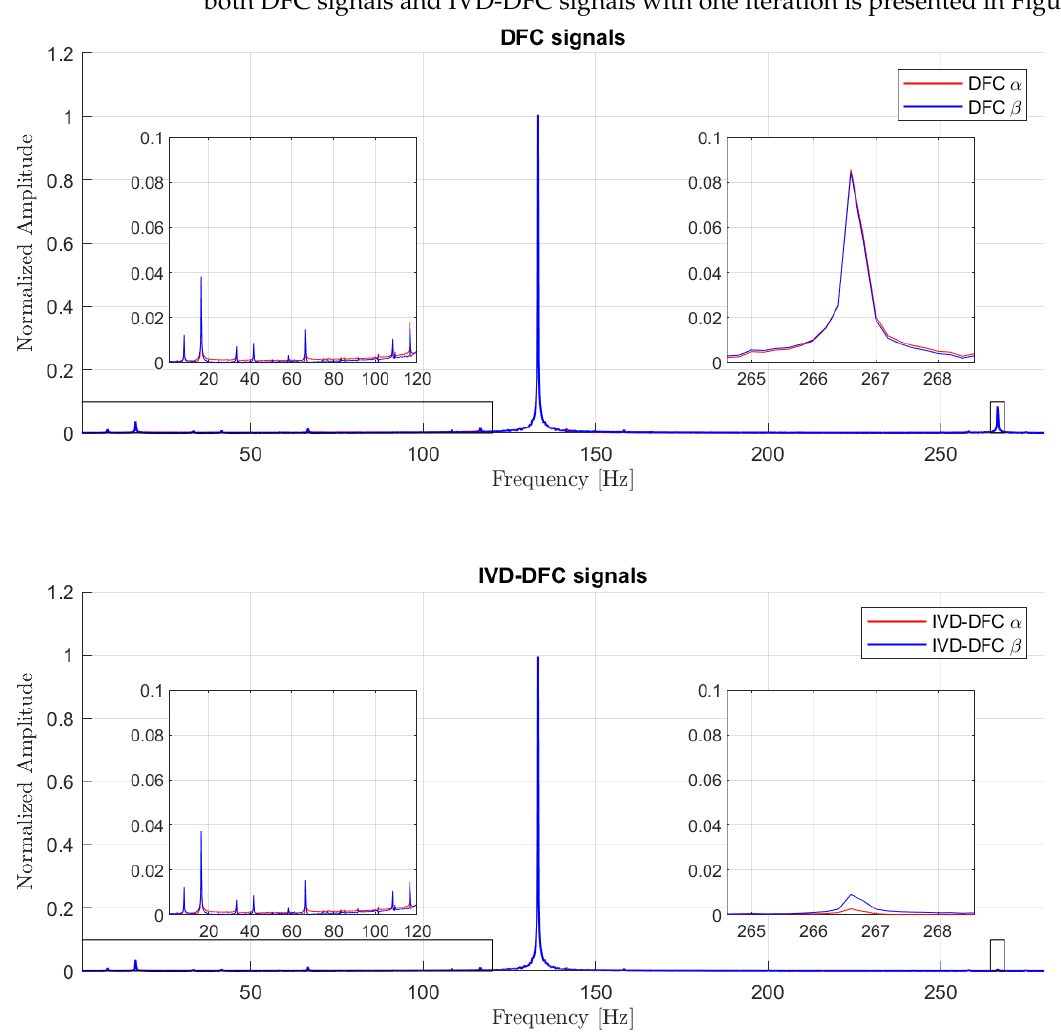
Figure 15. Frequency amplitude response comparison between DFC α - β and IVD-DFC α - β signals using one iteration. The rotor speed is 500 mechanical